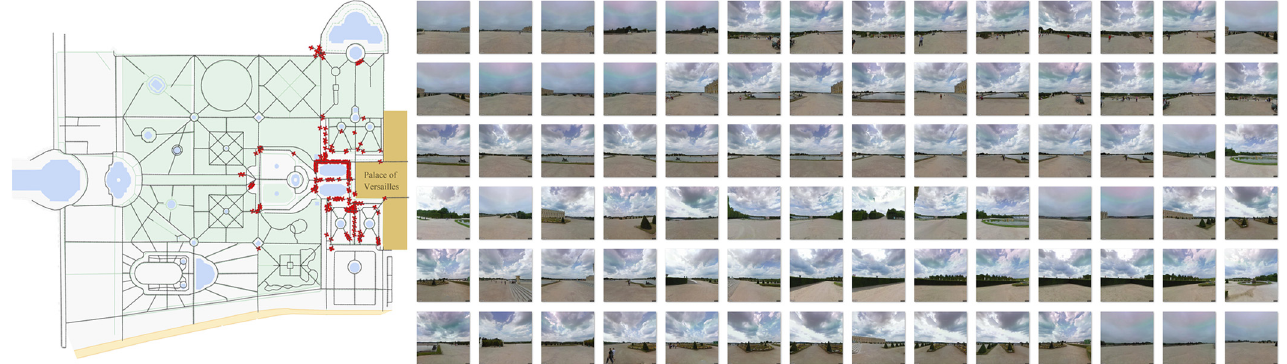
Figure 5. The distribution of ‘Simple’ scenario and its sample images in Gardens of Versailles. The Qinghui Garden does not contain any ‘simple’ scenarios.